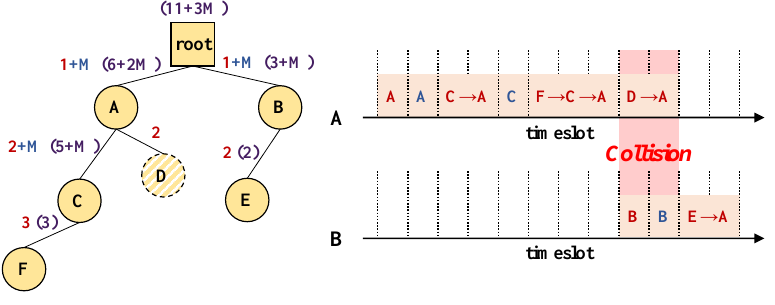
Figure 3. Slot violation